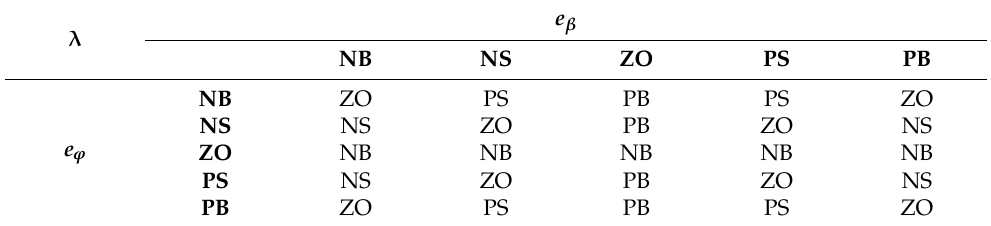
Table 2. The fuzzy control rules.